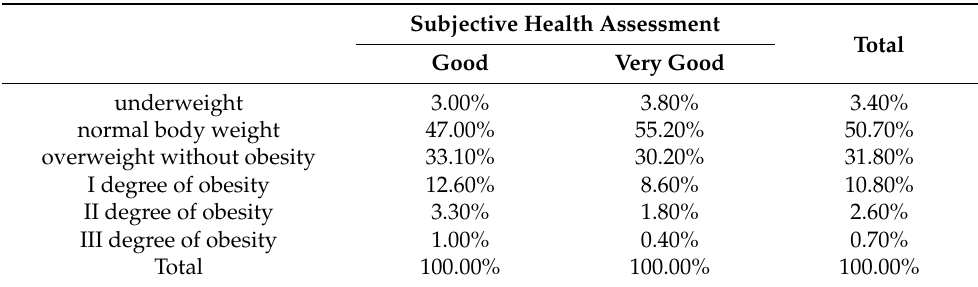
Table 6. Relationship between BMI and subjective assessment of health; data presented as percentage of the health assessment.